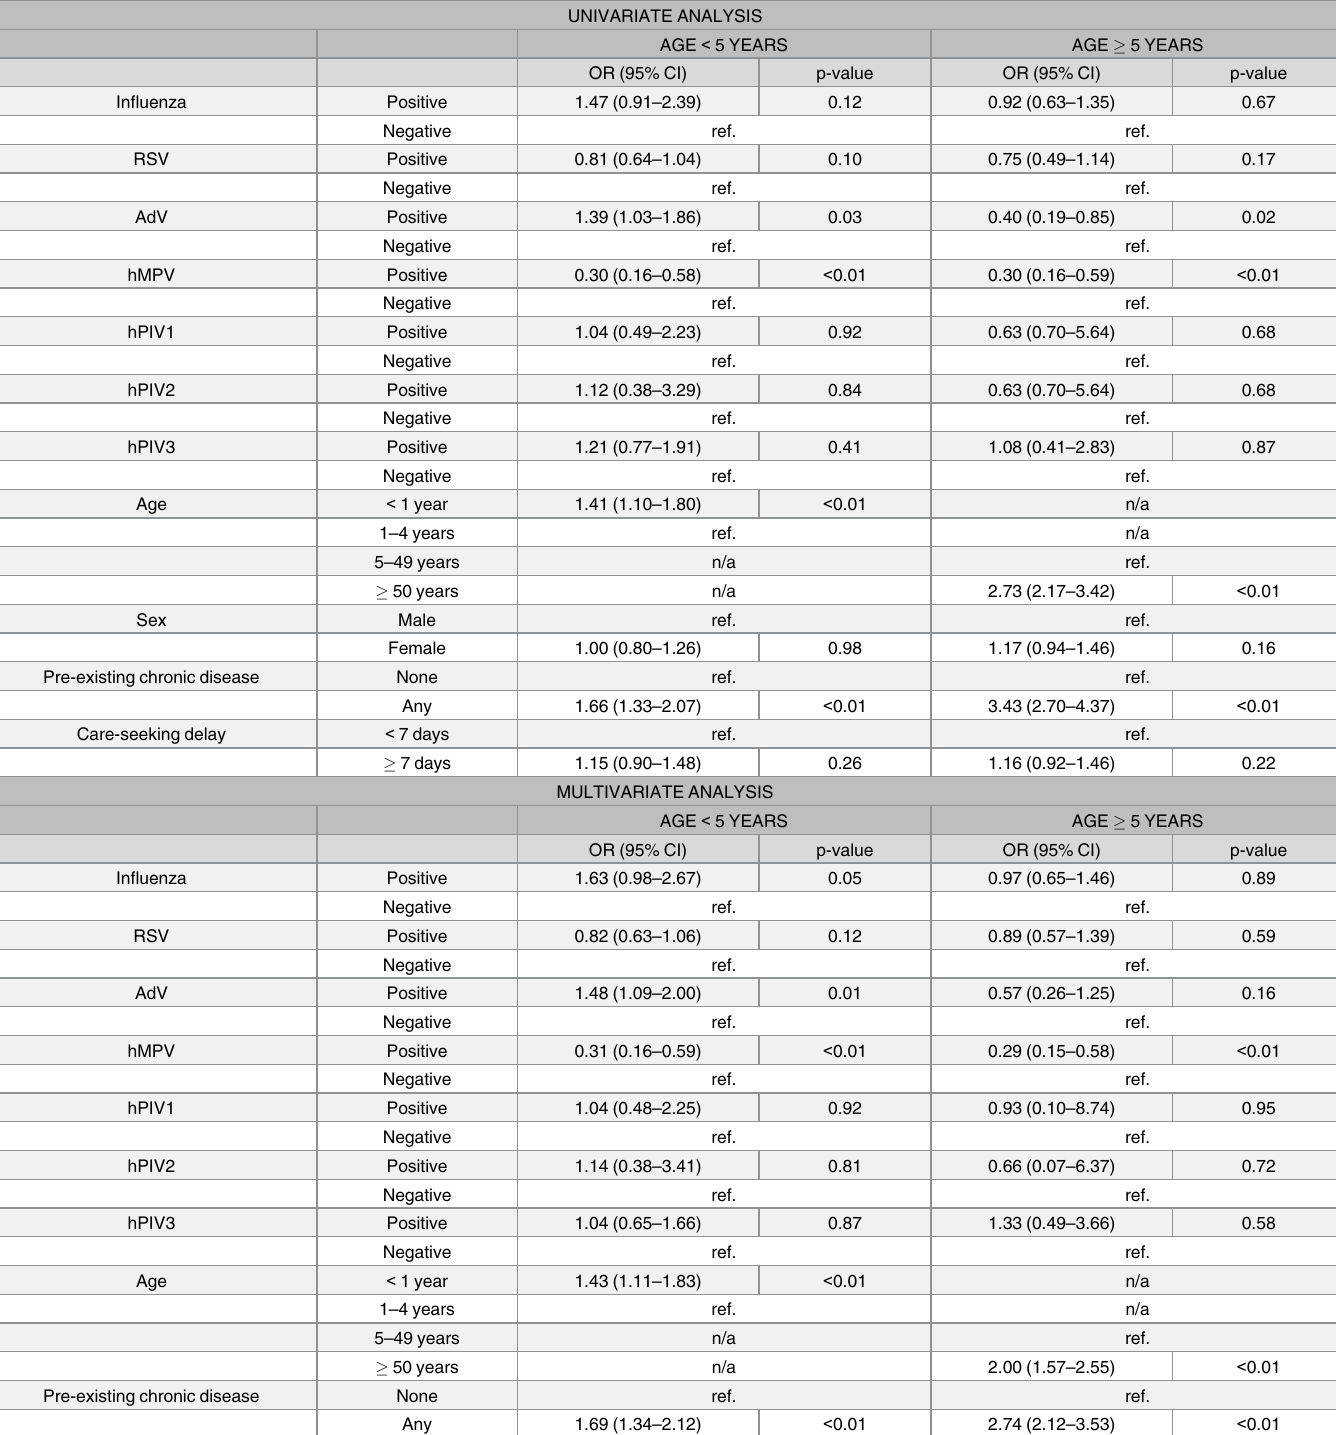
Table 5. Univariate and multivariate logistic regression examining predictors of severeoutcomes by age. Includesonly individualsfor whom testing for the full panel of viral respiratory pathogenswas performed and for whom data on predictor variablesare complete. Severe outcome is definedas